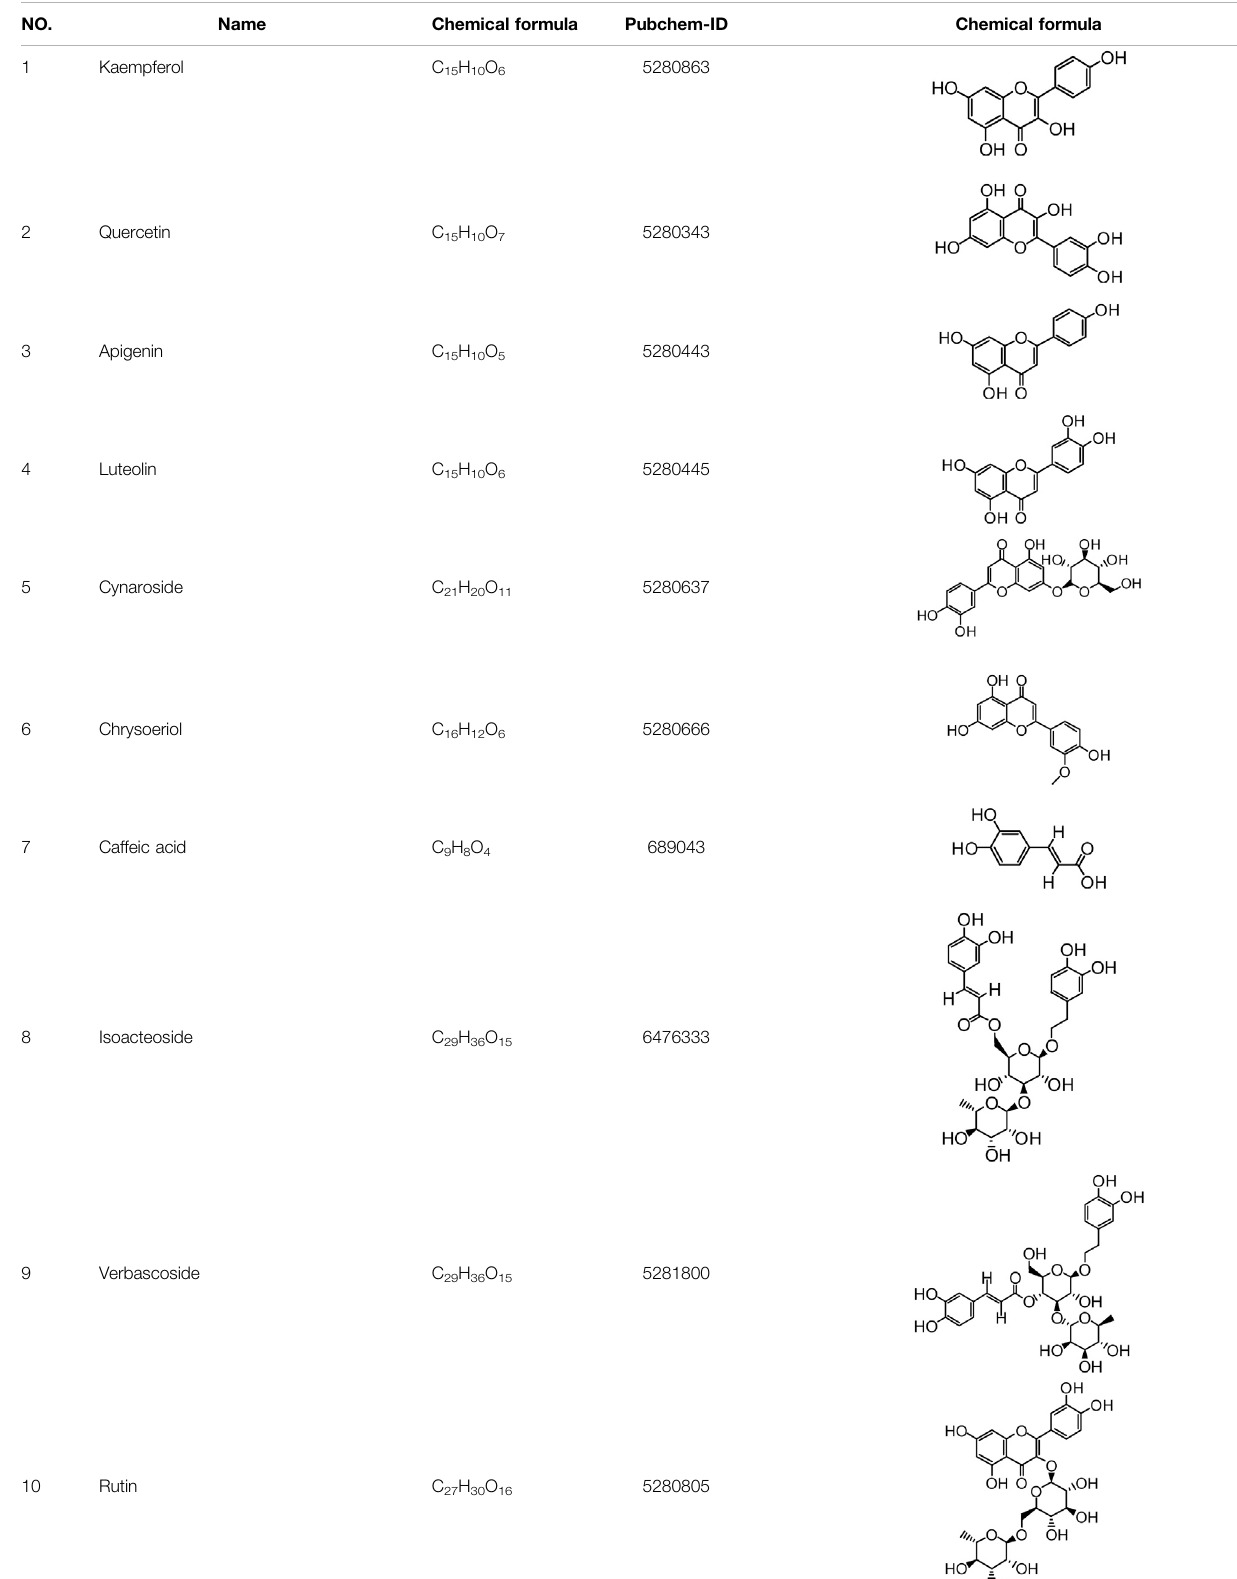
TABLE 2 | 36 compounds of O. vulgaris